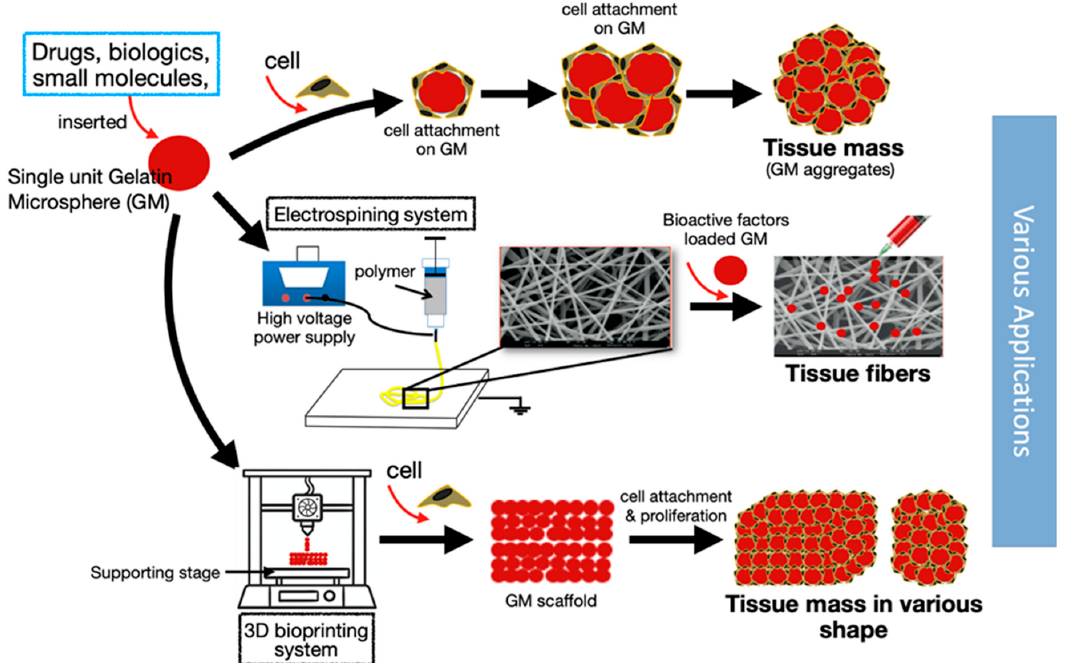
Figure 5. The gelatin microsphere (GM) serves as a building block in a variety of complex microsphere-based tissue